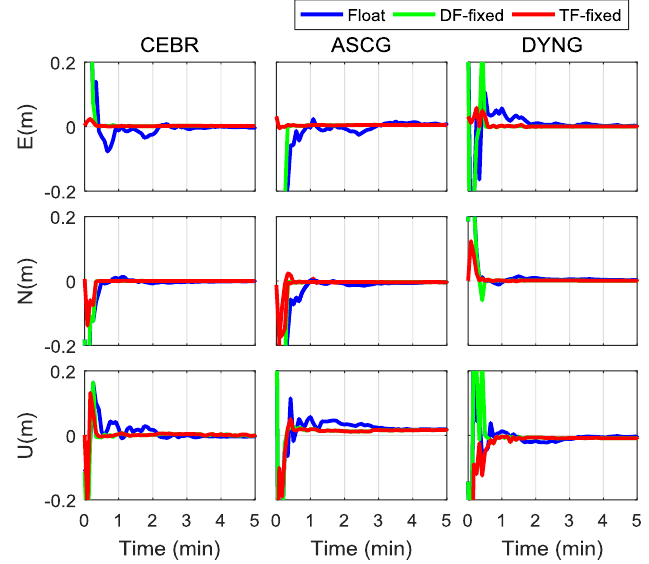
Figure 9. PPP fixed solutions with the augmentation of the dual- and triple-frequency observations of the 288-LEO constellation.